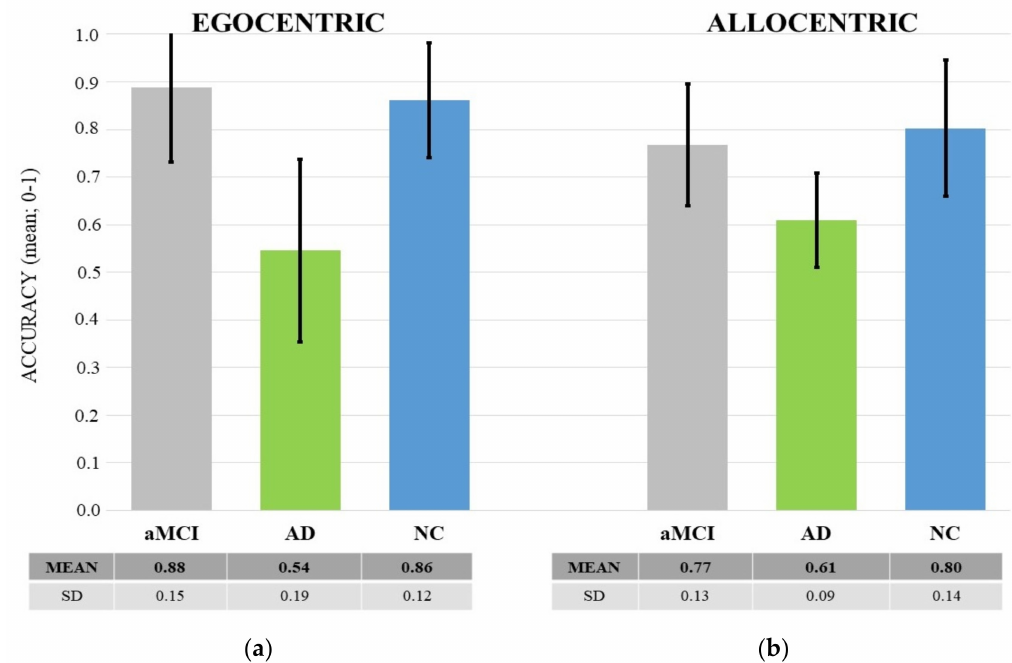
Figure 4. The graph shows the mean accuracy of egocentric ( a ) and allocentric ( b ) judgments as a function of the three groups of participants (aMCI, AD and NC). The black lines represent the standard deviation. Descriptive statistics are also shown in the table below the